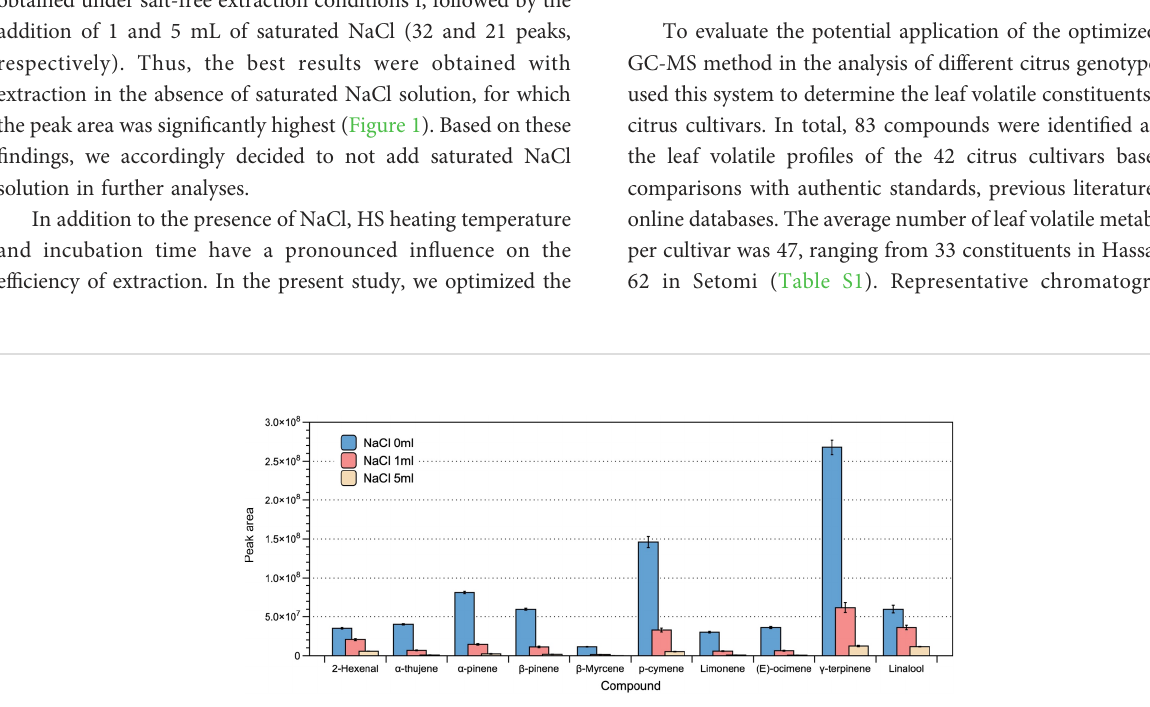
FIGURE 1 The effect of sodium chloride addition on the ef fi ciency of headspace extraction of volatile compounds. The bars and error bars respectively denote the means and 95% con fi dence intervals of three biological replicates. Compounds on the x-axis are listed in order of their sequence of elution, with corresponding peak areas shown on the